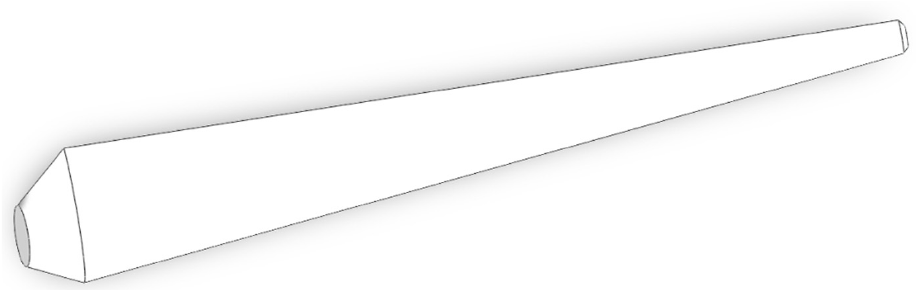
Figure 1. CAD design of a horizontal axis turbine blade.